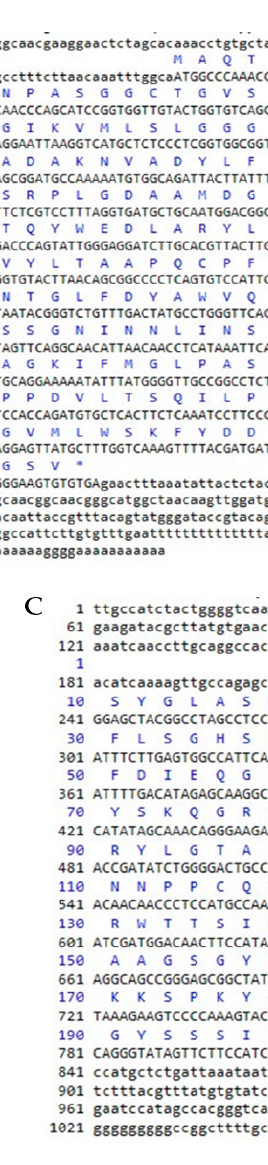
Figure 2. CHI gene cDNA sequence and its encoded amino acid sequence. The encoded protein starts from start codon ATG to stop codon TAG, and the predicted amino acid sequence is shown in one-letter code under the DNA sequence. Complete gene bands contain AATAA-box and poly ( A ) tail. ( A ) BgCHI , ( B ) KoCHI , ( C ) RsCHI . “*” represents the position of the end of protein translation in the fi gure.